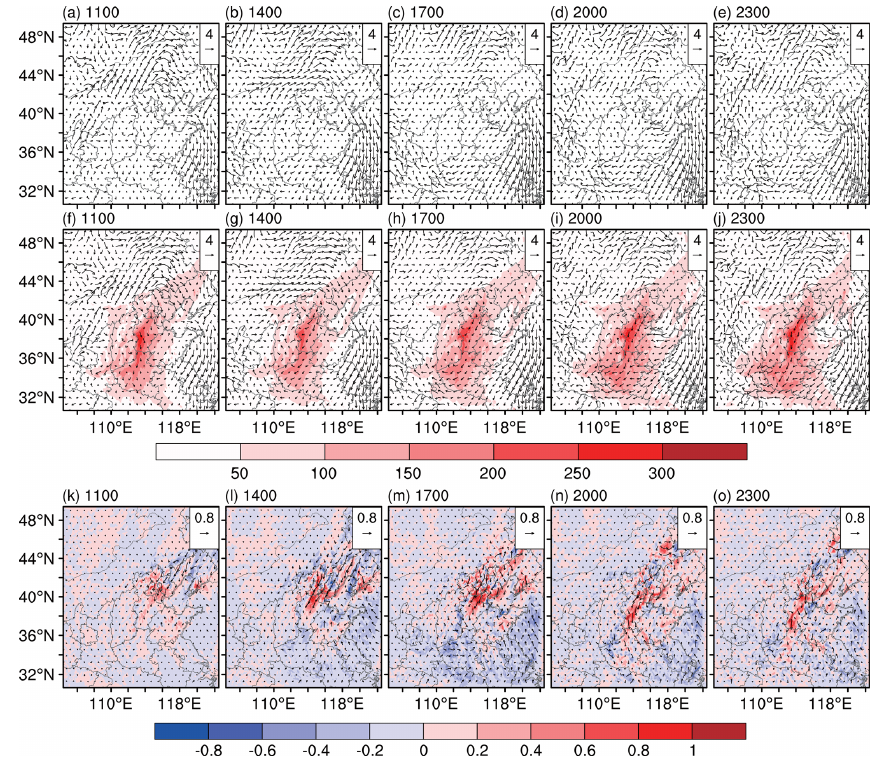
Figure 15. The 10m wind (vector) at 11:00, 14:00, 17:00, 20:00 and 23:00LT in (a–e) NoAero and (f–j) Aero averaged during 6 to 10 December 2015, shadings in (f–j) are simulated PM 2 . 5 concentrations (µgm − 3 ). (k–o) The difference of 10m wind (vector) and wind speed (shadings) between Aero and NoAero (Aero minus